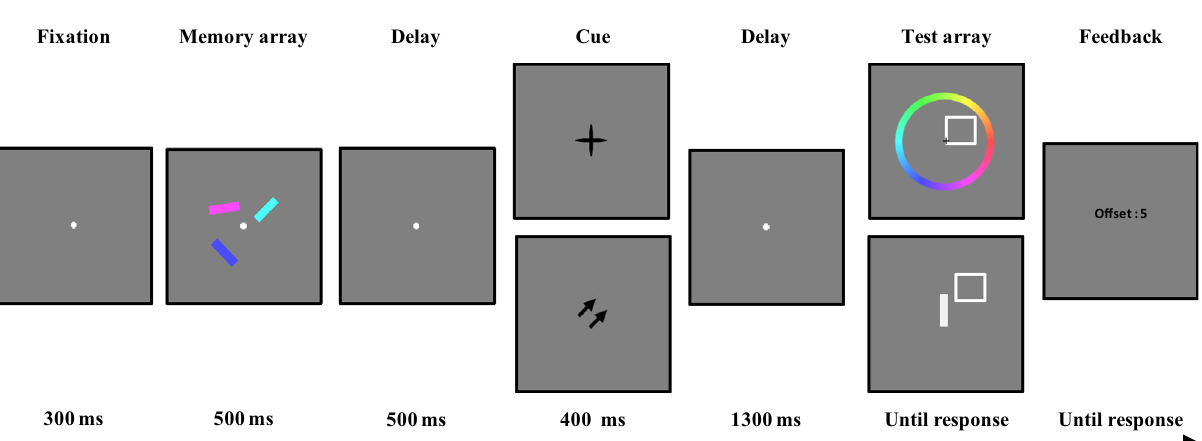
Figure 3. The task structure for the object-based cue task. The cue type in the upper row indicates the neutral retrocue, while the cue type in the lower row indicates the valid retrocue. For the test array, the upper row represents the color report trials, and the lower row represents the orientation report